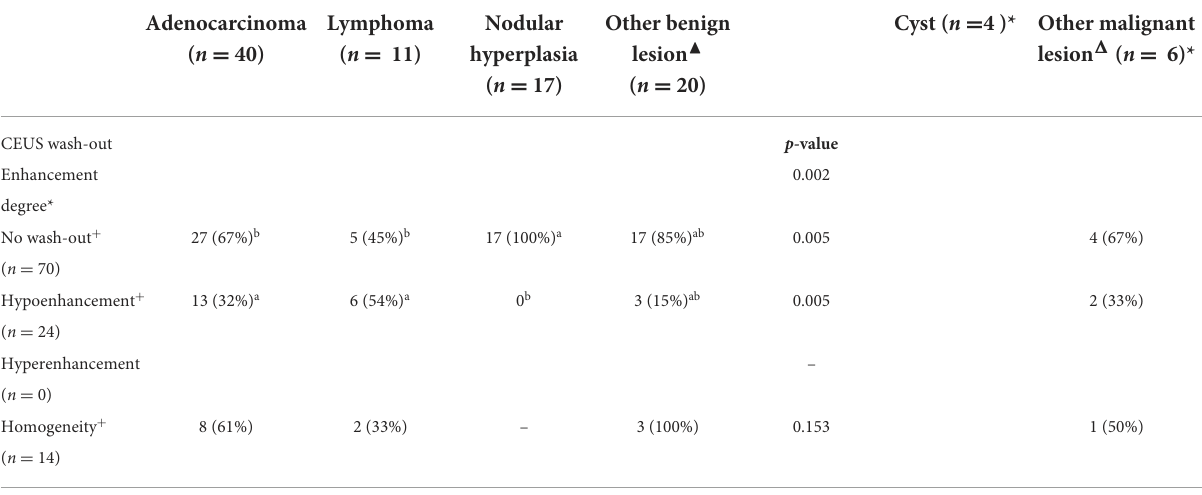
TABLE 4 Qualitative CEUS wash-out features of the lesions, along with cytopathological classification.